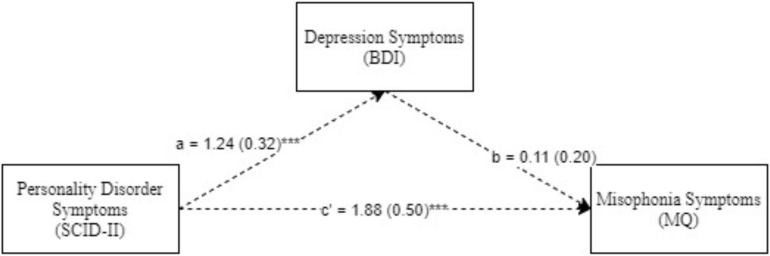
Personality disorder symptoms predicting mosophonia symptoms with anxiety symptoms as mediator. ***p< 0.001. Standard errors are in parentheses, solid lines represent significant indirect paths, a = unstandardized regression coefficient for the IV predicting the mediator, b = unstandardized regression coefficient for the mediator predicting the DV with IV and mediator in the model, c = unstandardized coefficient for the IV predicting the DV with the mediator in the model (direct effect). BAI, Beck anxiety inventory total score; MQ, Misphonia Questionaire total score; SCID-II, Structured clinical interview for DSM-IV (Axis II Disorders).